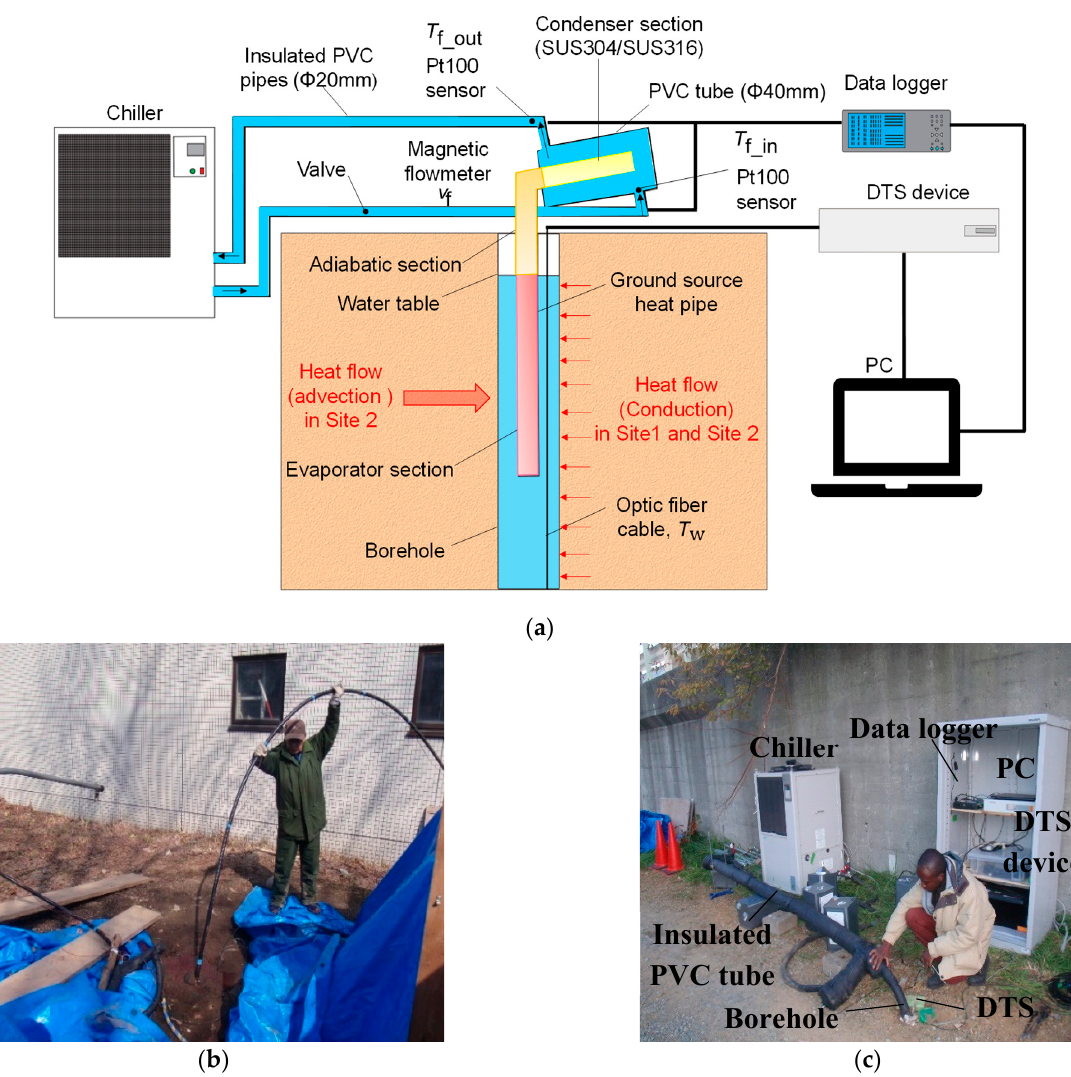
Figure 5. Schematic of the field experiment setup for a single heat pipe ( a ) with two explanatory pictures; heat pipe installation ( b ) and field experiment set up at Site 2 ( c ). In ( a ), the heat pipe is divided in different colors: red for the evaporator section, orange for the adiabatic section, and yellow for the condenser section. T f_out , T f_in and T w are the outlet and inlet temperatures of the circulation fluid in the pipe covering the heat pipe, and the water in the borehole,